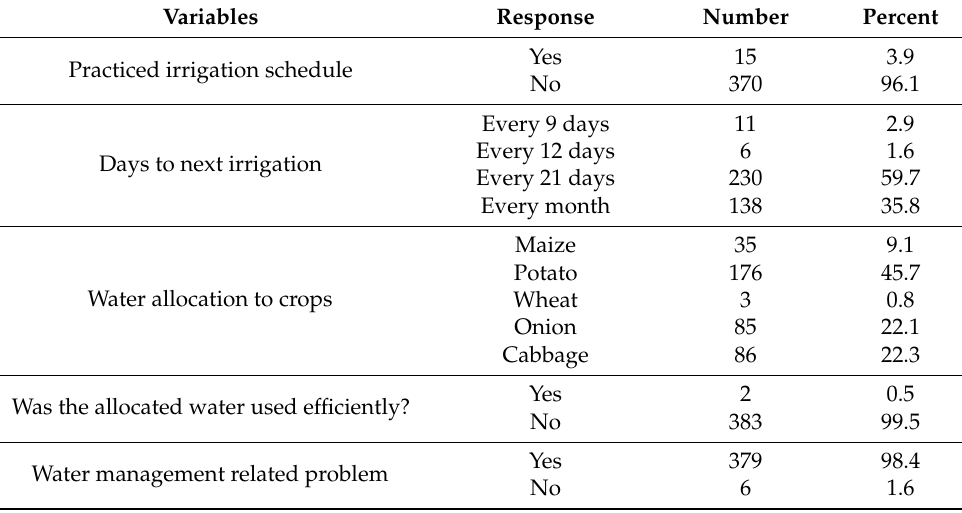
Table 6. HH’s perception of irrigation water management strategies.